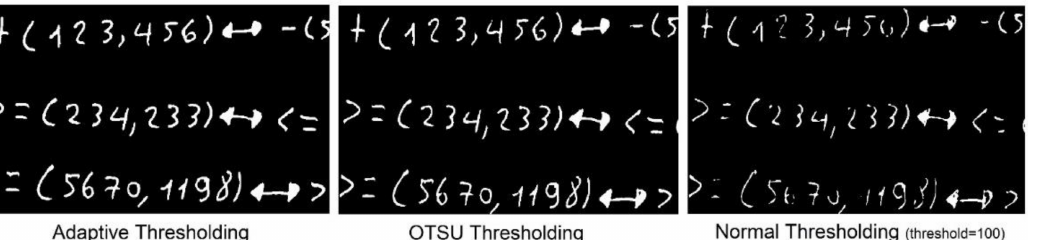
Figure 2. Comparison of thresholding algorithms.